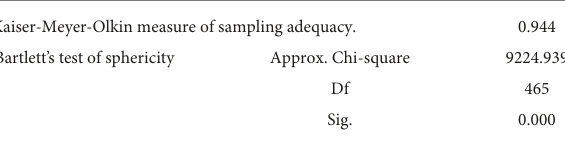
Kaiser-Meyer-Olkin measure of sampling adequacy.